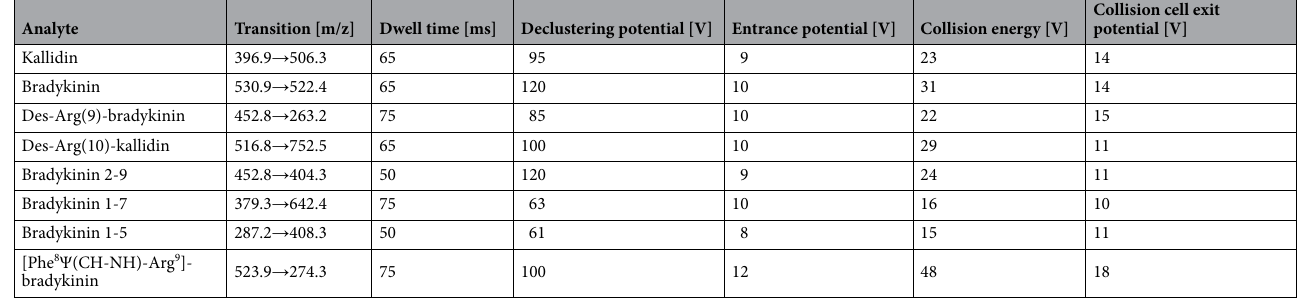
Table 1. Peptide specific transitions and voltage parameters for mass spectrometric detection. ms: milliseconds, m/z: mass-to-charge ratio, V: